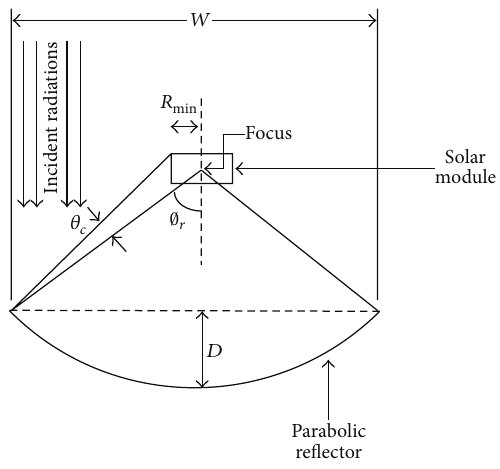
Figure 1: Basic geometry of parabolic trough